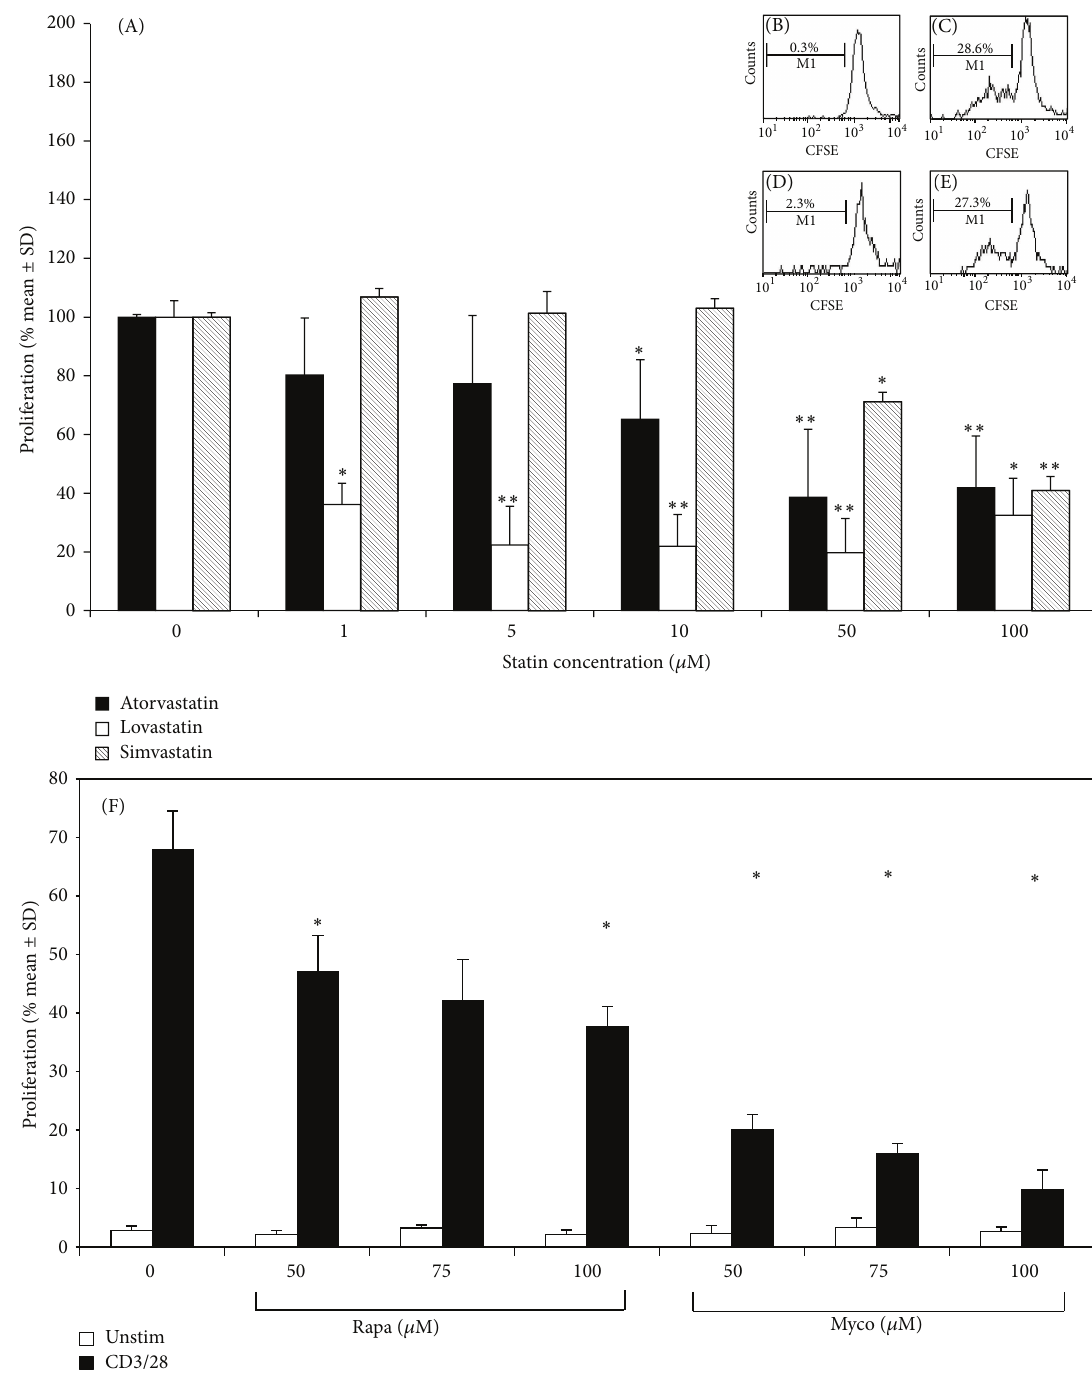
Figure 2: (A)–(F). Effect of statins on 𝛼 CD3/ 𝛼 CD28-stimulated T-cell proliferation. Each data point represents the mean % T-cell proliferation ± SD. Due to intersample variation, data from each experiment ( 𝑛 ≥ 3 ) were normalized against the positive control of % proliferated T cells without drug, allowing experiments to be pooled ( 𝑛 ≥ 3 ). ∗ 𝑃 < 0.05 and ∗∗ 𝑃 < 0.01 as compared to control. Insert: one representative FACS analysis is shown. (A), Control histogram showing % divided T cells (M1) in the absence of stimulation or statin. (B), % divided T cells after stimulation but no statin. (C), % divided T cells with the addition of atorvastatin (50 𝜇 M) as compared to stimulated control. (D), % divided T cells with the addition of atorvastatin (50 𝜇 M) and mevalonate (200 𝜇 M). (F), Effect of rapamycin and mycophenolate on 𝛼 CD3/ 𝛼 CD28-stimulated T-cell proliferation. Each data point represents the mean % change in T-cell proliferation ± SD. Due to intersample variation, data from each experiment ( 𝑛 ≥ 3 ) were normalized against the positive control of % proliferated T cells without drug, allowing experiments to be pooled ( 𝑛 ≥ 3 ). ∗ 𝑃 < 0.05 and ∗∗ 𝑃 < 0.01 as compared to